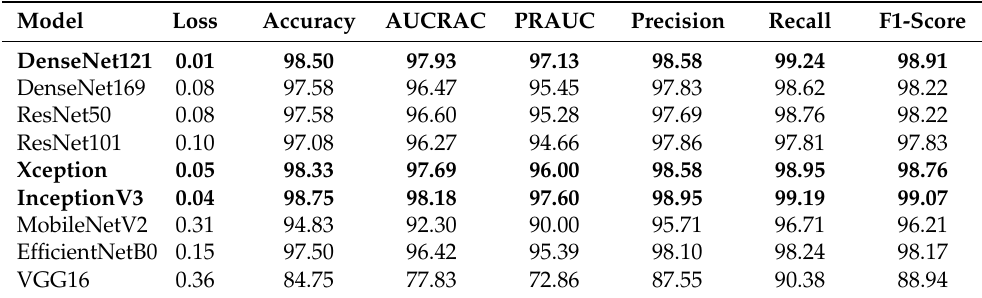
Table 2. The performance analysis of various models for gender classification on test dataset when trained with facial images where individuals either wear the mask fully, half, partially, or do not wear one at all (4 ways/styles of wearing).